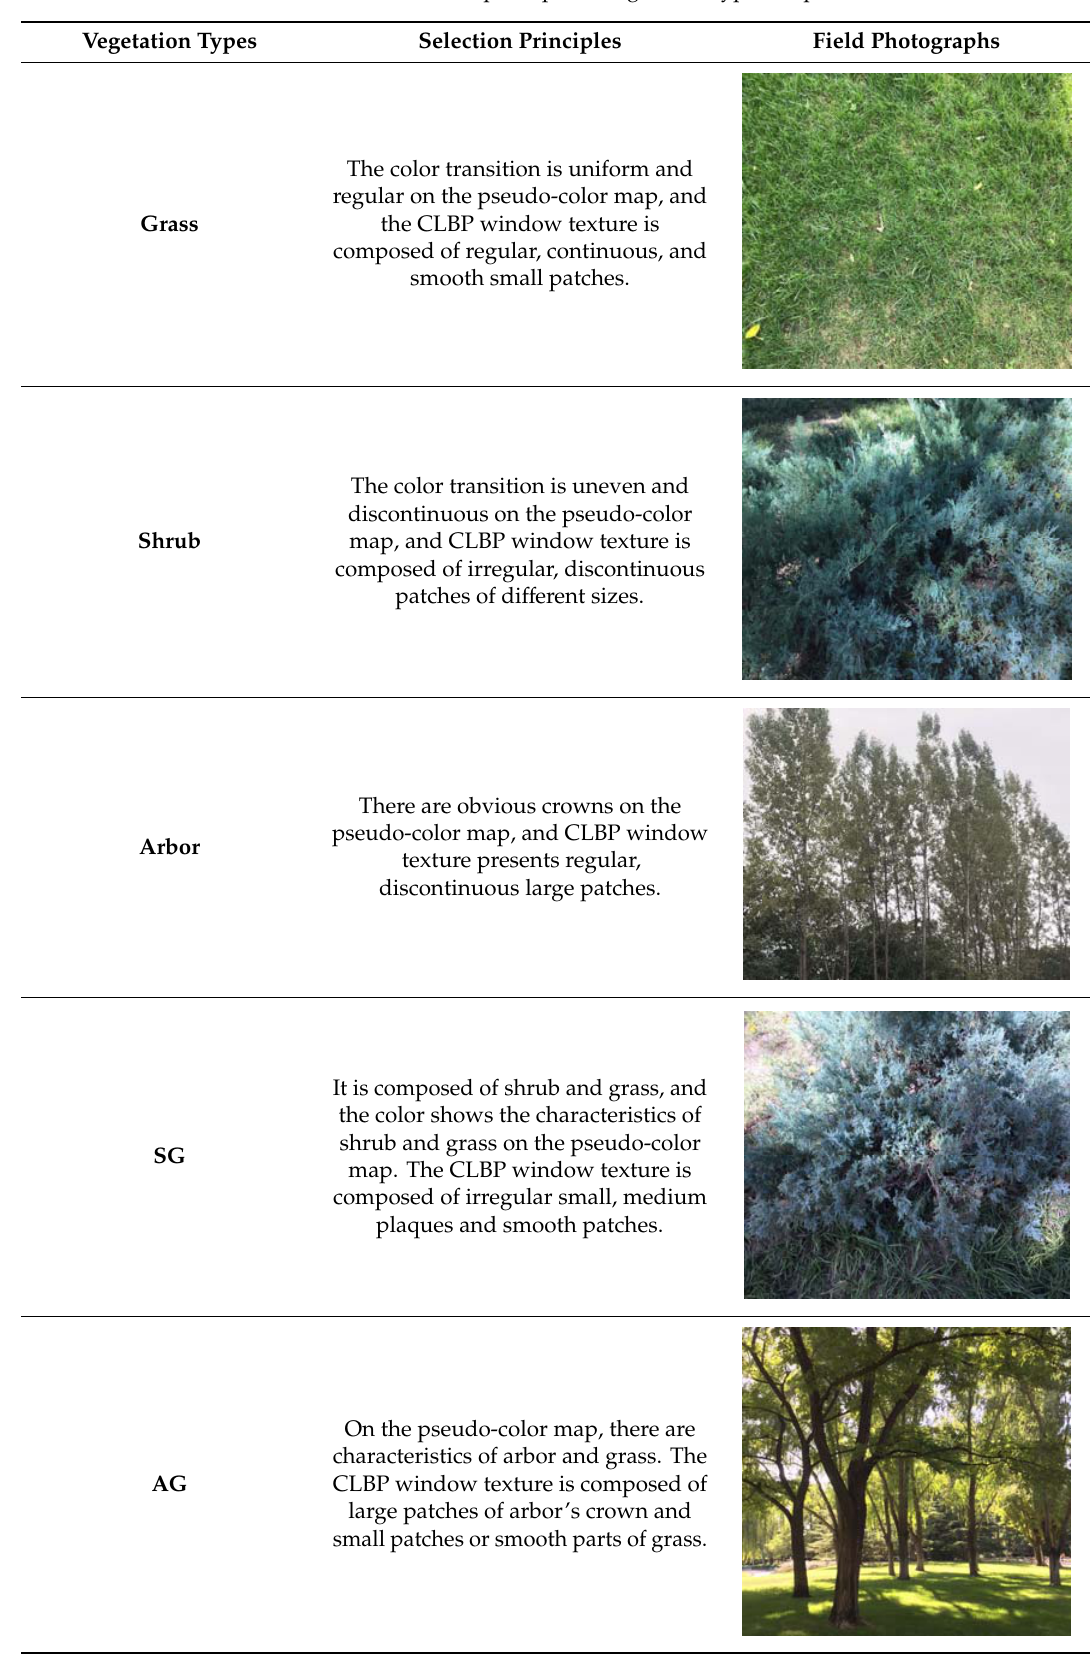
Table 5. The selection principle of vegetation type samples.